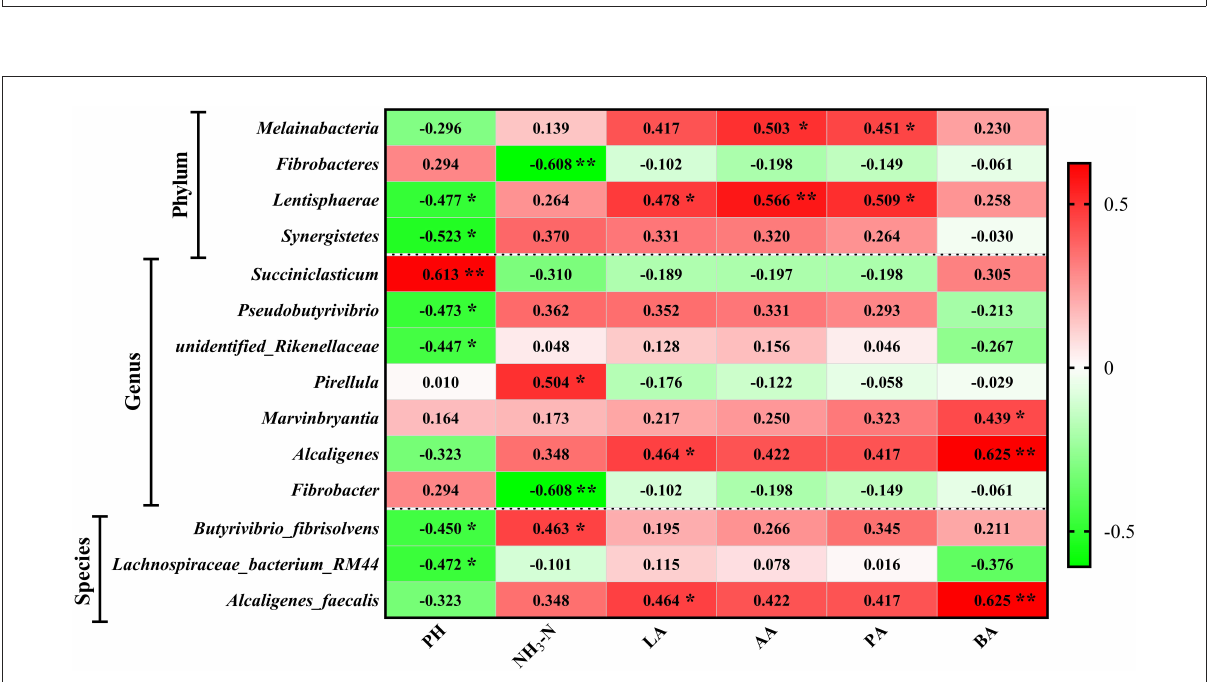
FIGURE8 Correlation of fermentation parameters and flora. *indicates P < 0.05, and **indicates P <